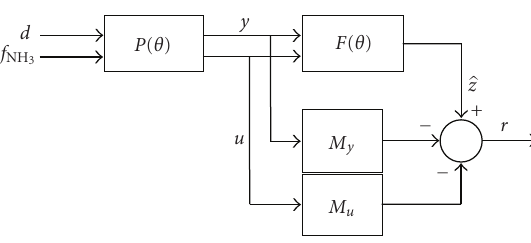
Figure 5: The time varying parameter Q ext ( t ).